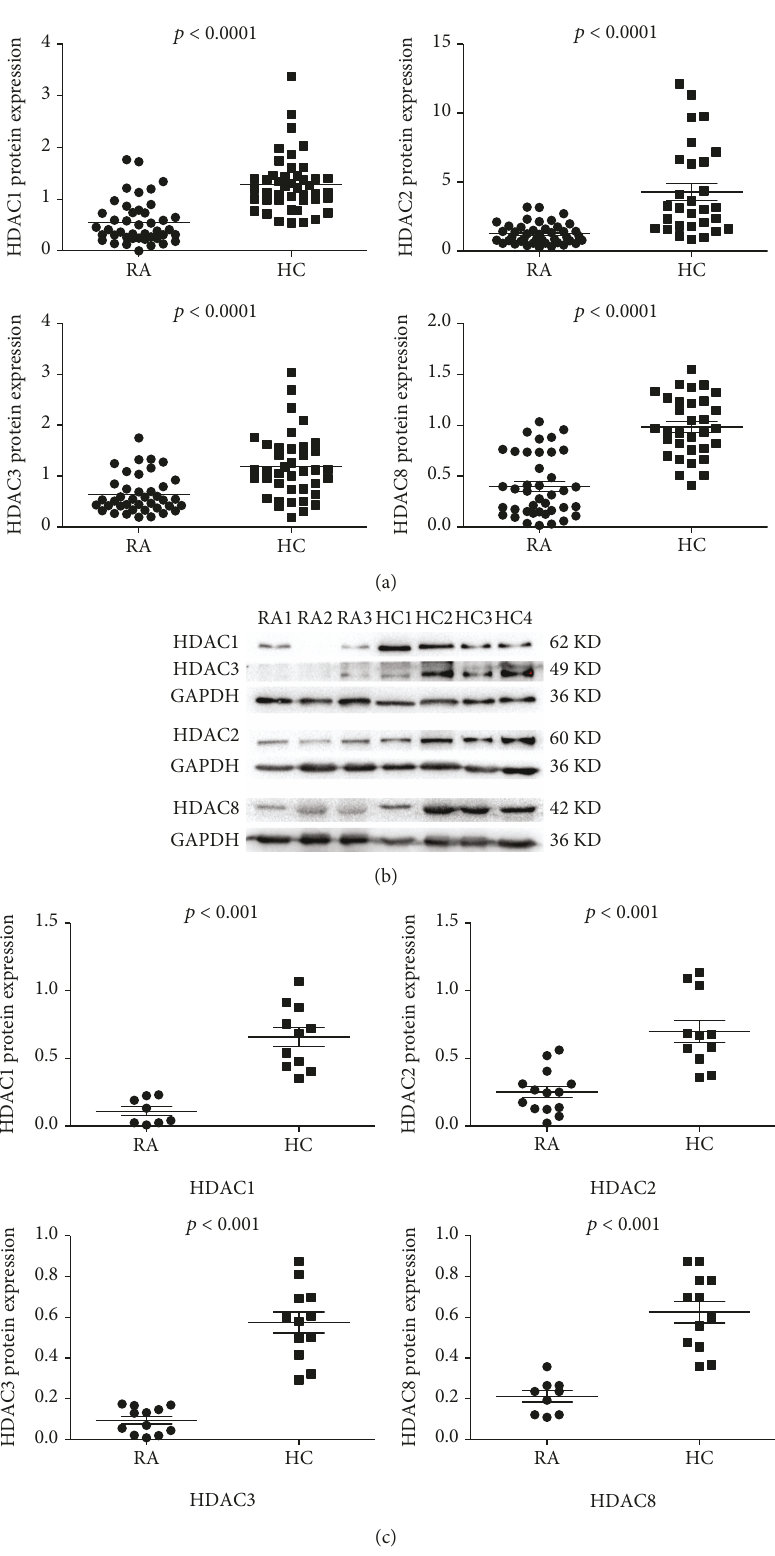
Figure 1: Decreased mRNA and protein expression of class I HDACs in PBMCs from patients with RA. (a) The mRNA expression of class I HDACs in the PBMCs of patients with RA ( n = 46 ) and HCs ( n = 46 ) was detected by real-time PCR. (b) Expression of class I HDAC proteins was detected using Western blot. (c) Relative protein expression of class I HDACs in PBMCs of patients with RA and HCs was normalized to GAPDH. The p values were determined using the Mann – Whitney